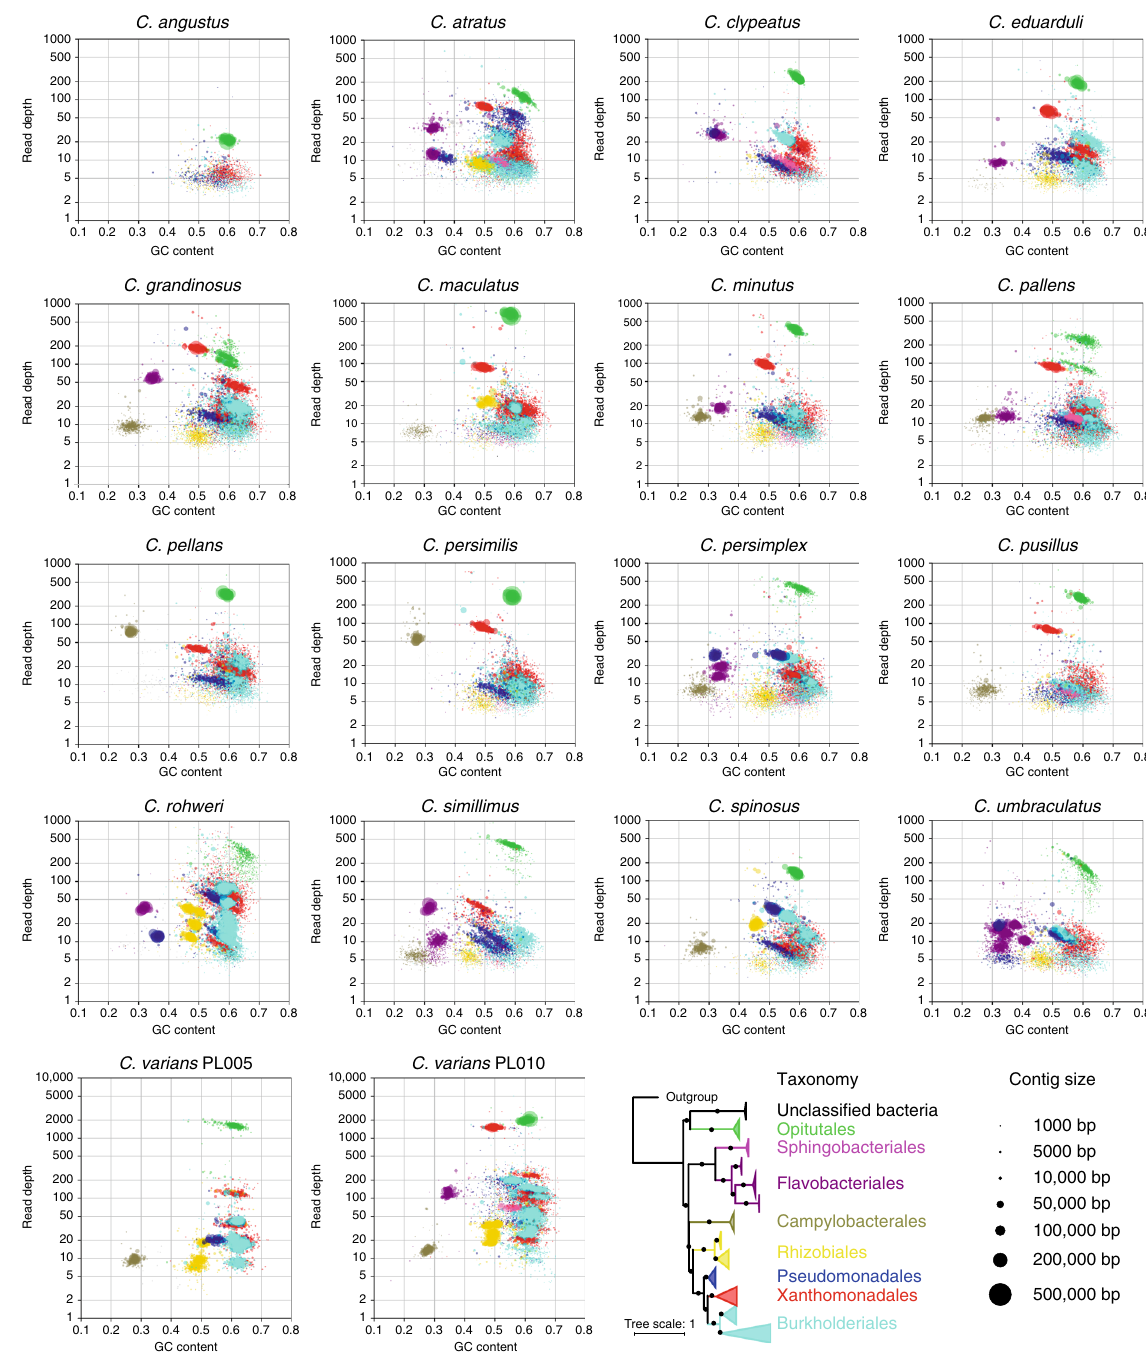
Fig. 3 Taxon-annotated GC-coverage plots for 18 Cephalotes metagenomes reveal strong microbiome conservation. Assembled scaffolds in each metagenome are plotted based on their %GC content ( x -axis) and their depth of sequencing coverage ( y -axis, log scale). Bacterial genomes vary in %GC genome content and core symbionts show variable abundance; these plots, thus, illustrate the co-existence of numerous dominant symbiont strains in Cephalotes worker guts. The phylogeny at lower right, based on 16S rRNA sequences from our metagenomes, identi fi es the Cephalotes -speci fi c clades from which nearly all of our sequence data have been obtained. Colors on the phylogeny match those in the blob plots, illustrating the taxa to which scaffolds were assigned. Circle size indicates length of each scaffold. Not shown here are scaffolds binning to Hymenoptera or to unclassi fi ed organisms. Note that for each metagenome library, DNA was obtained from a total of 10 workers from a single